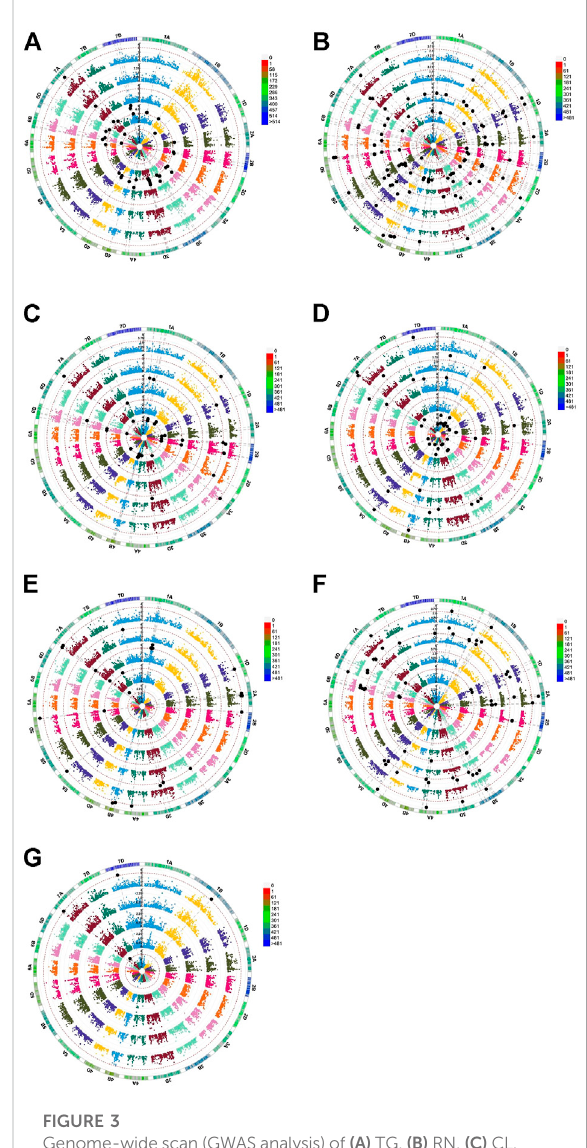
FIGURE 3 Genome-wide scan (GWAS analysis) of (A) TG, (B) RN, (C) CL, (D) SL, (E) RL, (F) R/S, and (G) SVI. S0 (inner circle), S1 ( fi rst outer circle), S2 (second outer circle), R_S1 (third outer circle), and R_S2 (fourth outer circle) are circular Manhattan plots in which the chromosomes are plotted at the outermost circle. The thin dotted red line indicates signi fi cance at p < 0.001 ( − log10 = 3 or more) beyond which an association is counted as a true association (highlighted black dots). The scale between chromosomes 7D and 1A indicates the LOD threshold. The colored boxes outside on the top right side indicate the SNP density across the genome where green to red indicates less to more dense.